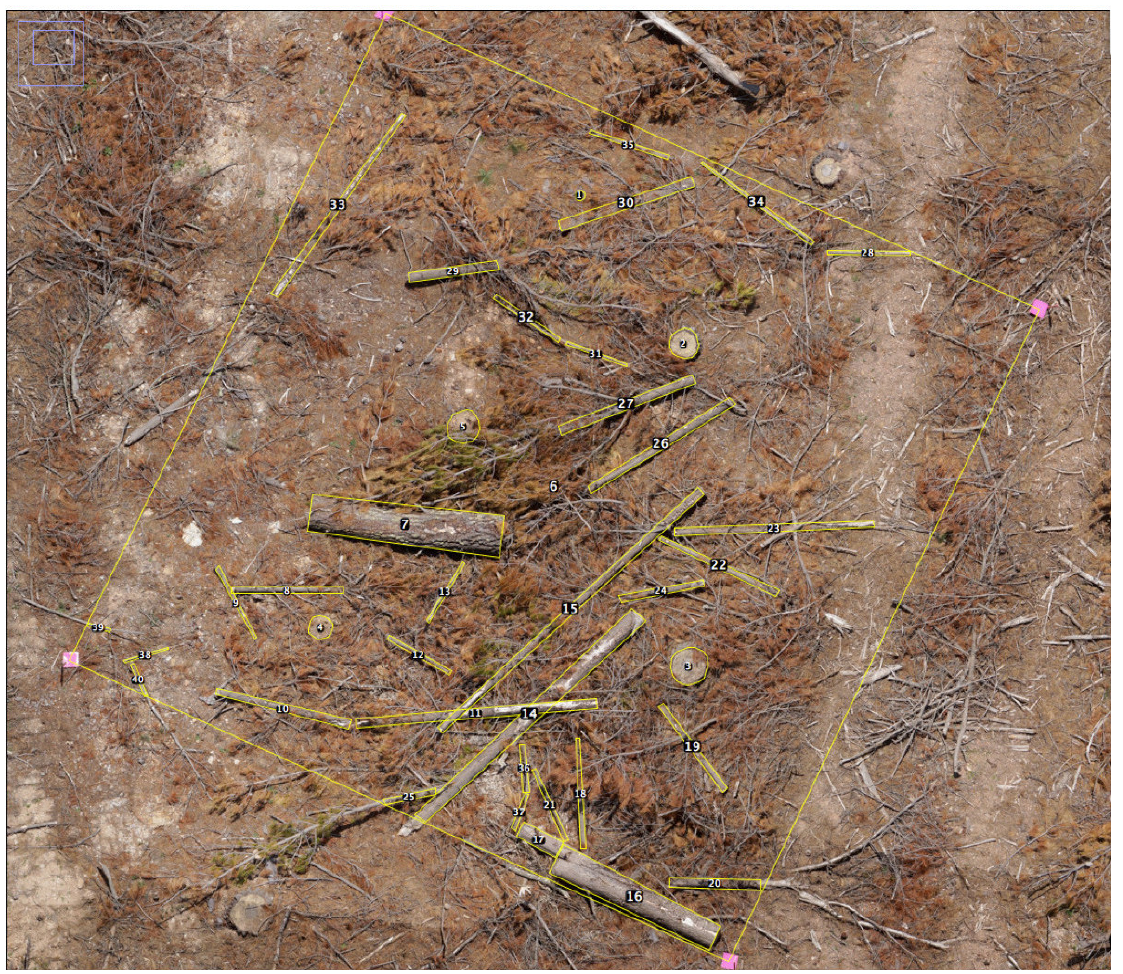
Figure 3. Imagery and annotation data for plot number 4 of 9: photomosaic layer with overlaid plot boundaries (10 × 10 m quadrat) and digitally annotated locations/boundaries of all coarse woody debris with diameter greater than 2.5